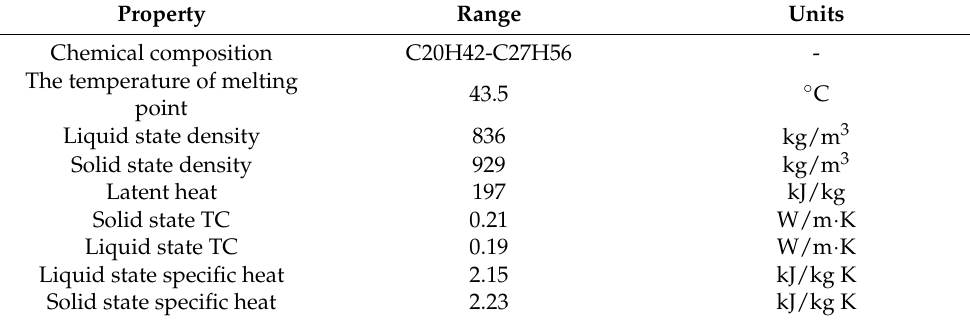
Table 4. Iraqi paraffin properties